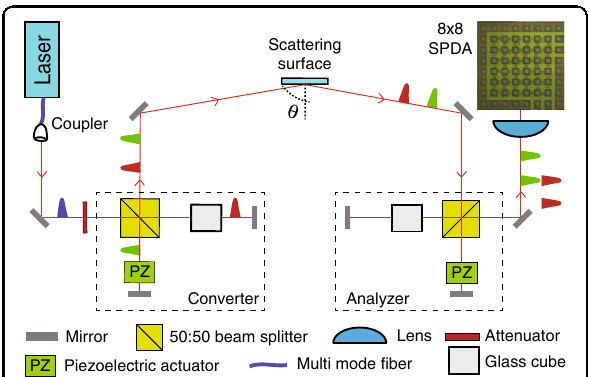
Fig. 5 The experimental setup. The Converter creates two pulses separated by 0.6 ns. The path difference between the two short-long (SL) and long-short (LS) pulses can be adjusted using the piezoelectric actuator placed in the short arm. A glass cube is present in the long arm of both interferometers to make the interferometers balanced in the spatial domain. The Analyzer recombines the pulses coming via SL and LS paths and the output is studied by the 8 × 8 SPDA. During the initial alignment, the incident angle was θ = 25° ( fi gure not to scale)